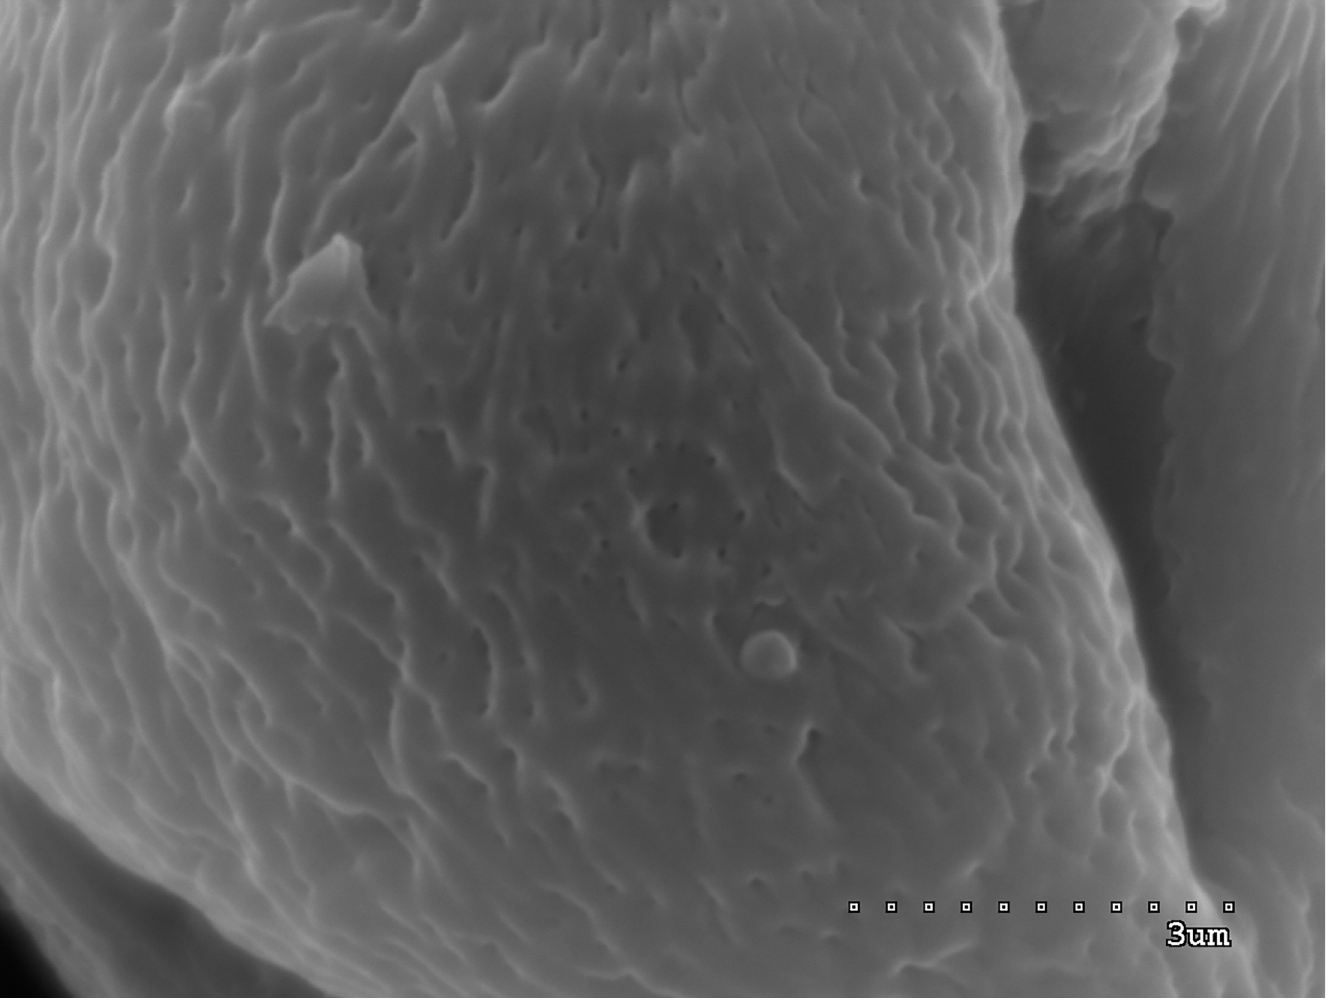
Fig 6. Striate exine ornamentation with small, circular